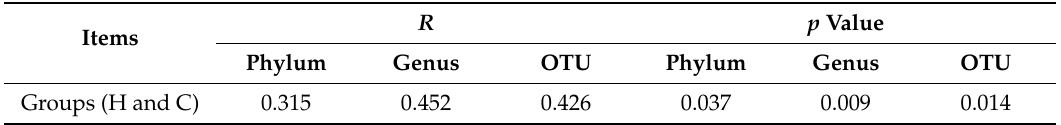
Table 2. Analysis of similarities (ANOSIM) for rumen microbial composition at the phylum, genus and OTU